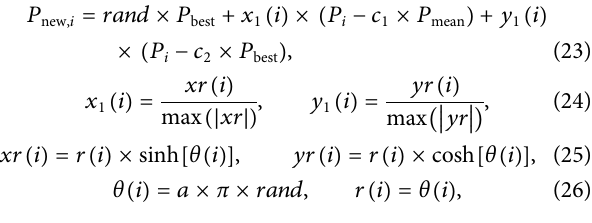
Frontiers in Energy Research |